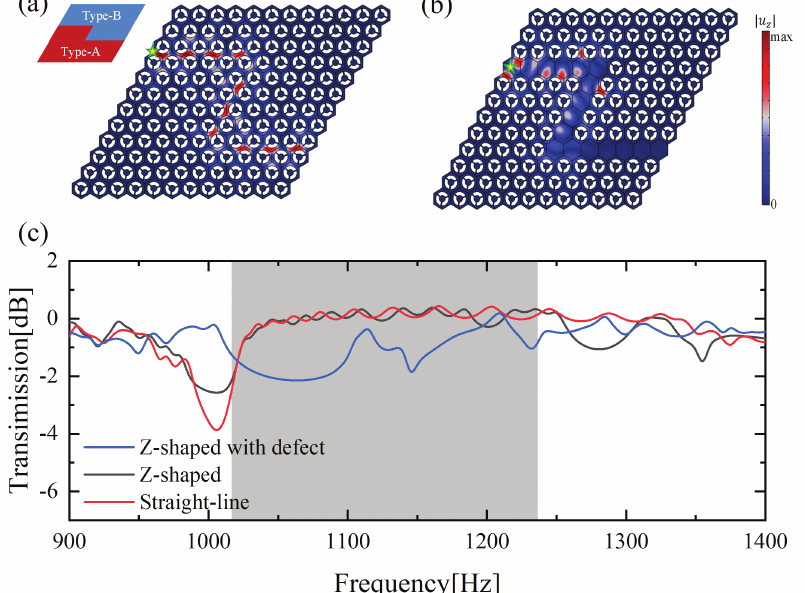
Figure 6. Displacement field intensity distribution and transmission curve under an out-of-plane harmonic excitation of 1133.5 Hz: ( a ) displacement field distribution of the Z-shaped waveguide; ( b ) displacement field distribution of the traditional defect waveguide with the Z-shaped channel; ( c ) transmission curve of these two structures of ( a , b